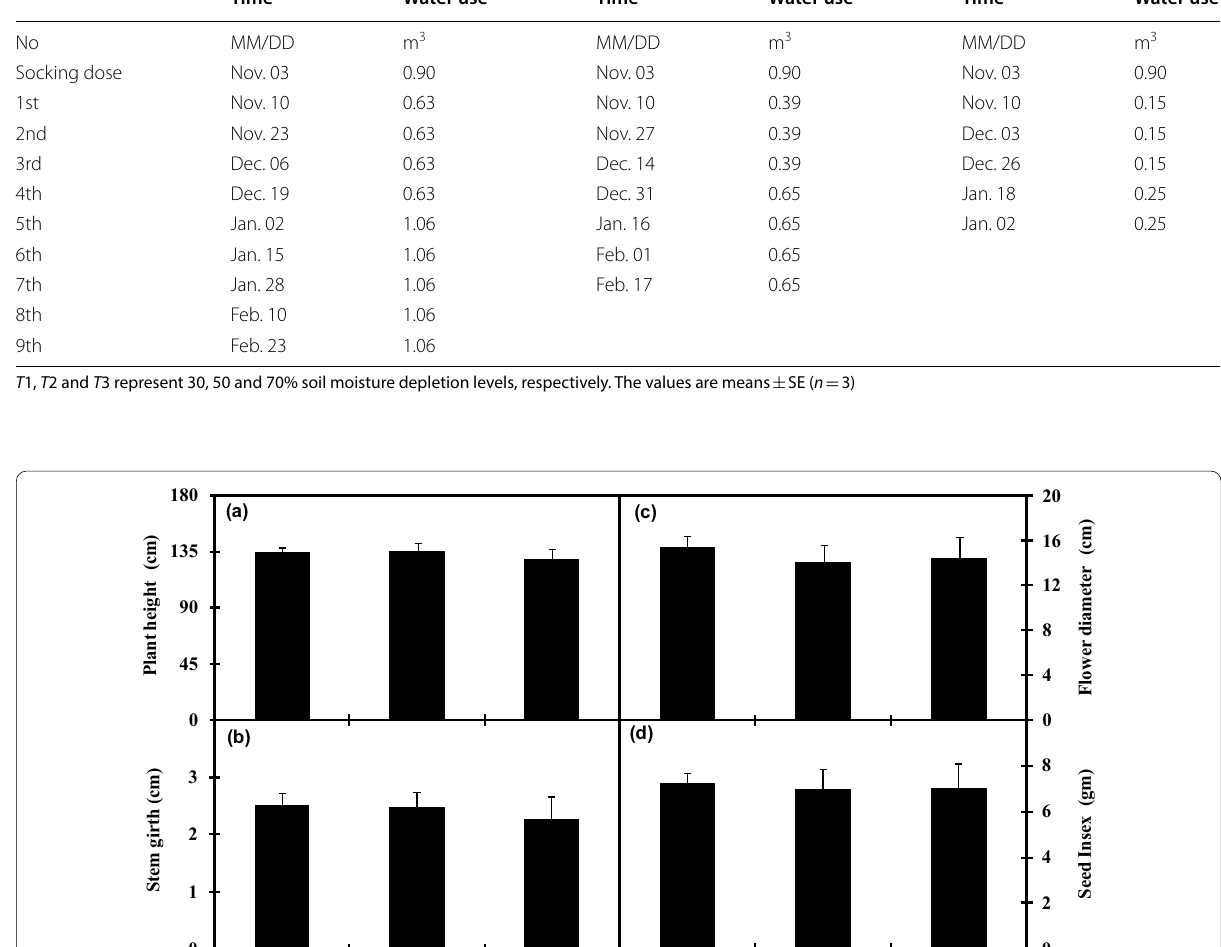
Table 2 Date wise irrigation and volume of water applied to sunflower crop under different soil moisture regimes Irrigation T1 T2 T3 Time Water use Time Water use Time No Socking dose